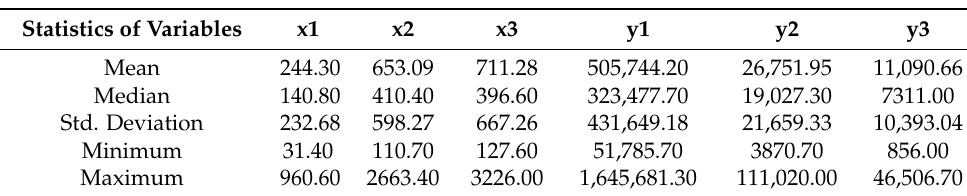
Table 2. Input and output statistics.